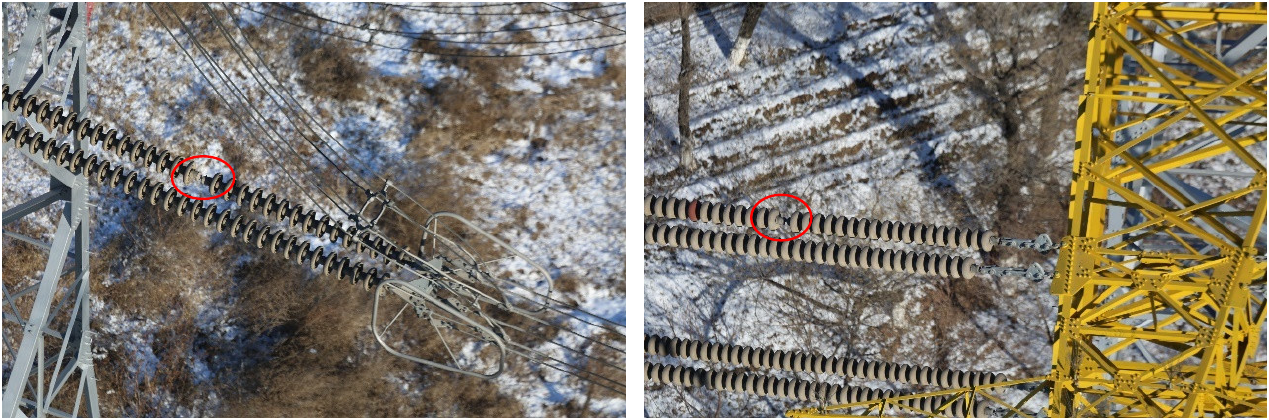
taneous explosion of glass insulator string are shown in Figure 14.